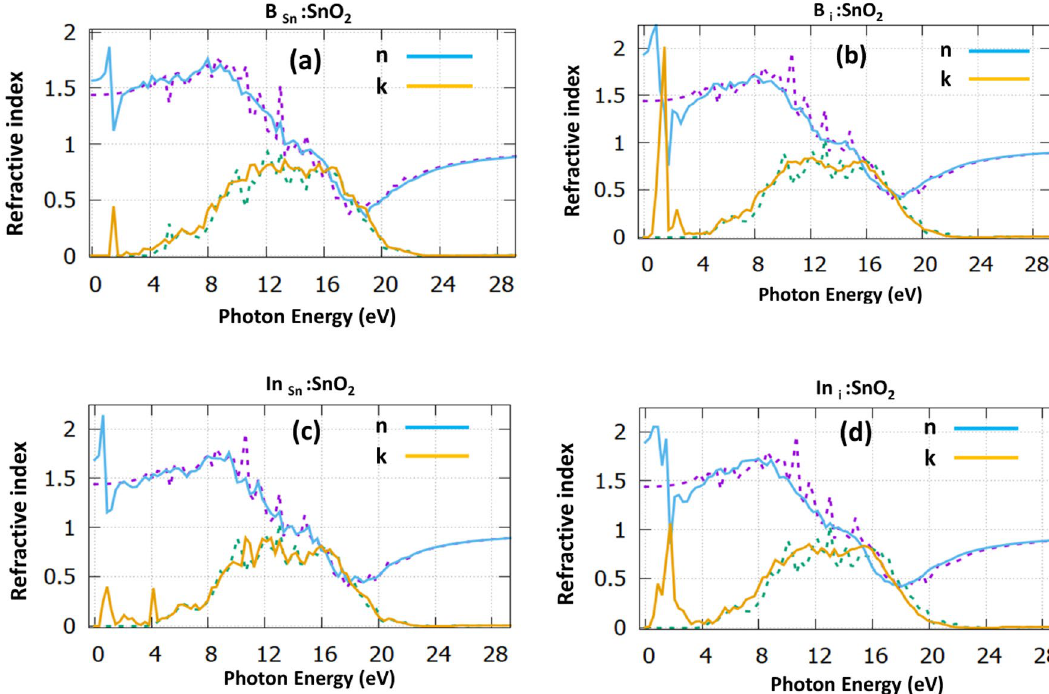
Figure 4. The refractive index for ( a ) B Sn :SnO 2 , ( b ) B i :SnO 2 , ( c ) In Sn :SnO 2 and ( d ) In i :SnO 2 . The dotted purple and dotted green, correspond to the dielectric function of the undoped SnO 2 .